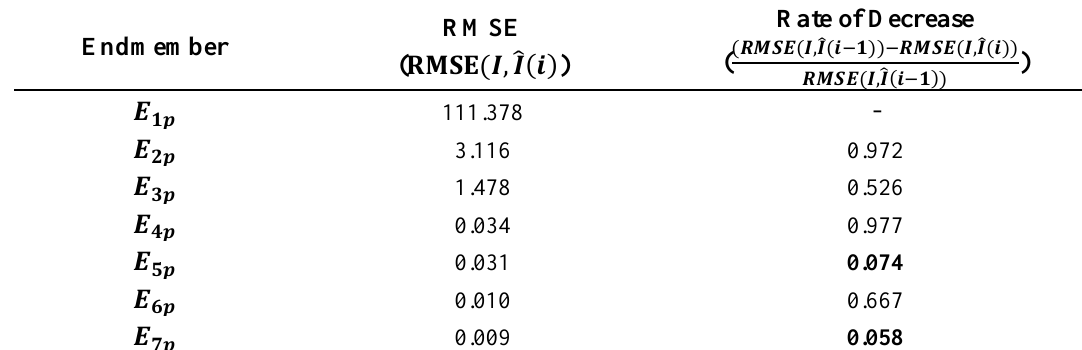
Table 1. RMSEs and rates of change of extracted endmembers. The values shown in bold italics are those of endmembers for which the rate of decrease is less than